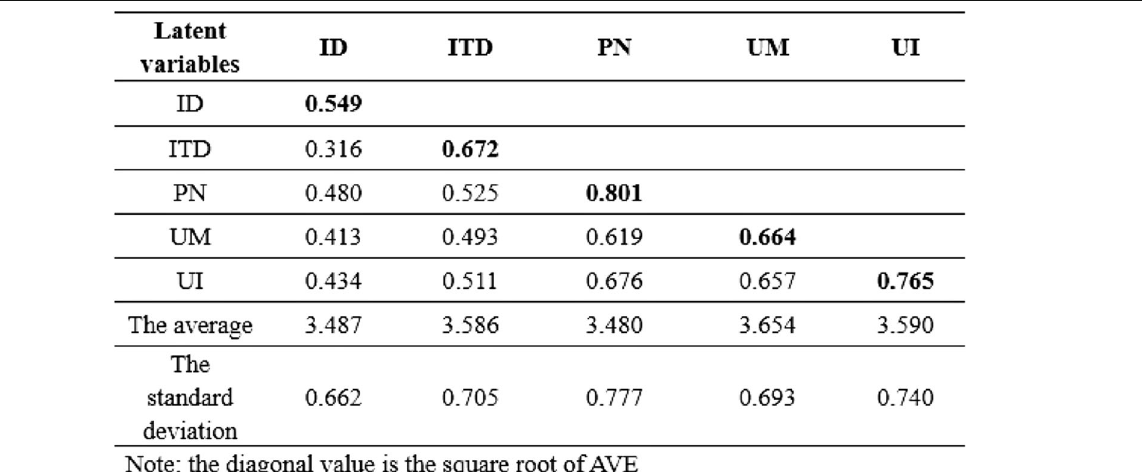
Table 3 Square root of AVE of latent variables and correlation